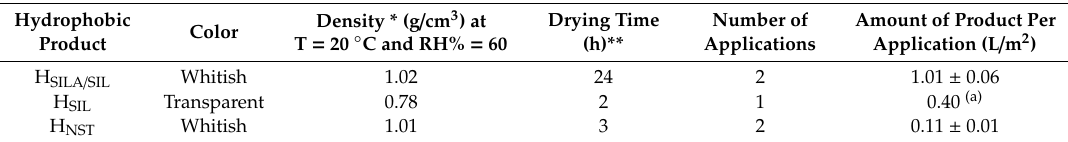
Table 2. Chemical and physical characteristics and amount of product used in the application of the hydrophobic